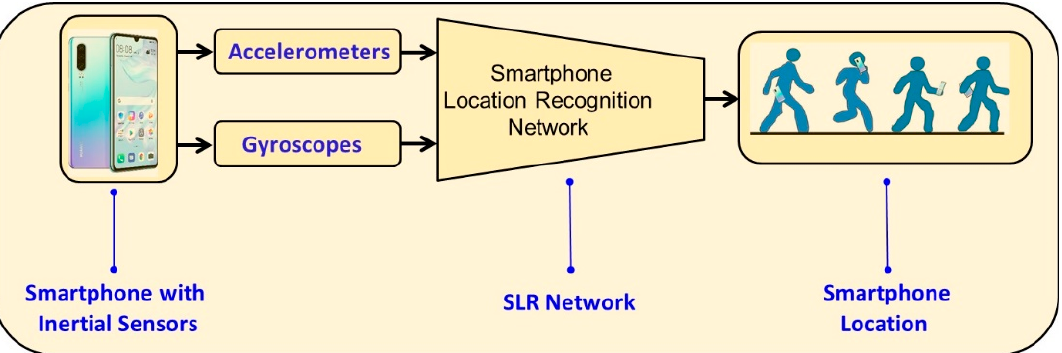
Figure 1. SLR framework block diagram. The input to the network is the inertial sensors’ measurements and the output of the network is the smartphone location.